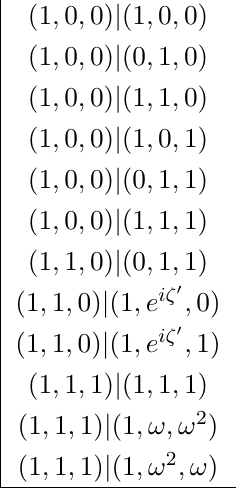
( ’; ’ 0 ). (cid:1)(3 n 2 ) p = 3~ r , thus (cid:16) 0 = (cid:6) (cid:25)= 6. 3 2